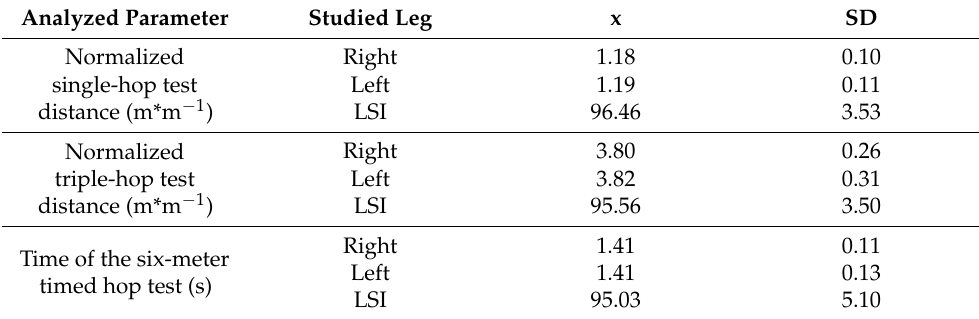
Table 1. Summary of the results obtained from the performed battery of tests.